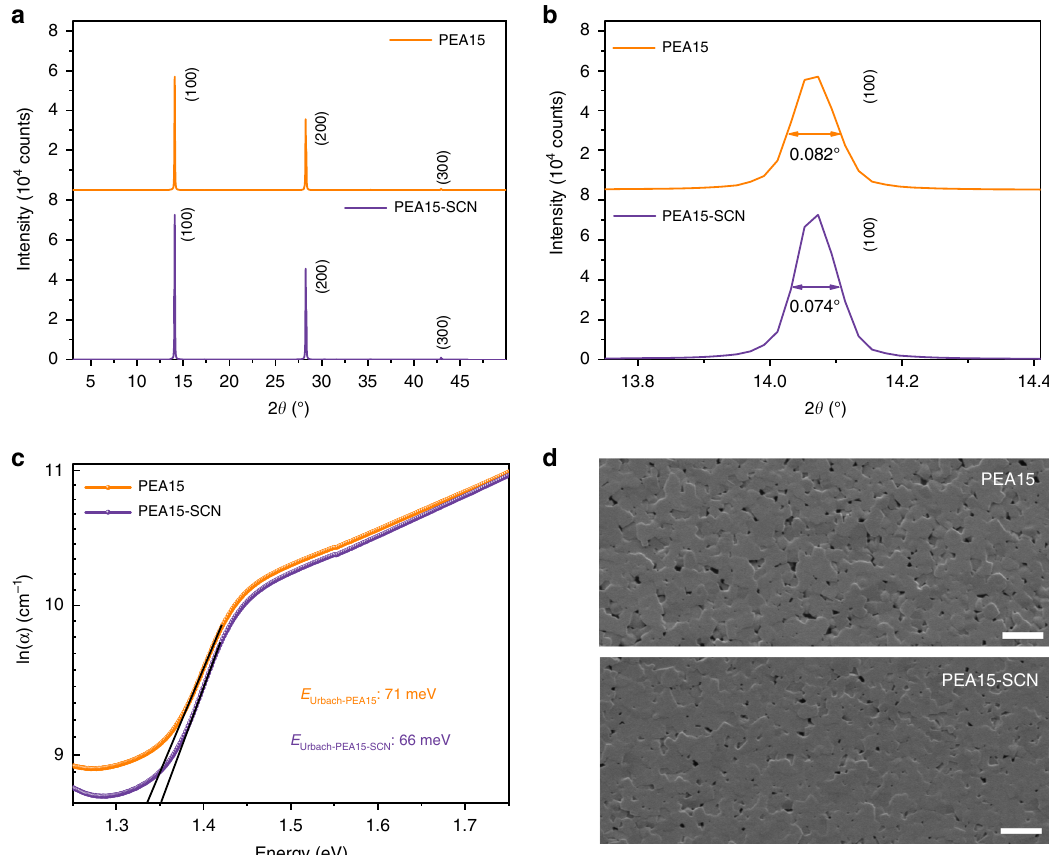
Fig. 1 Perovskite fi lm characterization. a XRD spectra of perovskite fi lms and b the corresponding FWHM values of (100) peak. c The Urbach energy of perovskite fi lms. d SEM images of perovskite fi lms. The scale bar is 1 µ m.